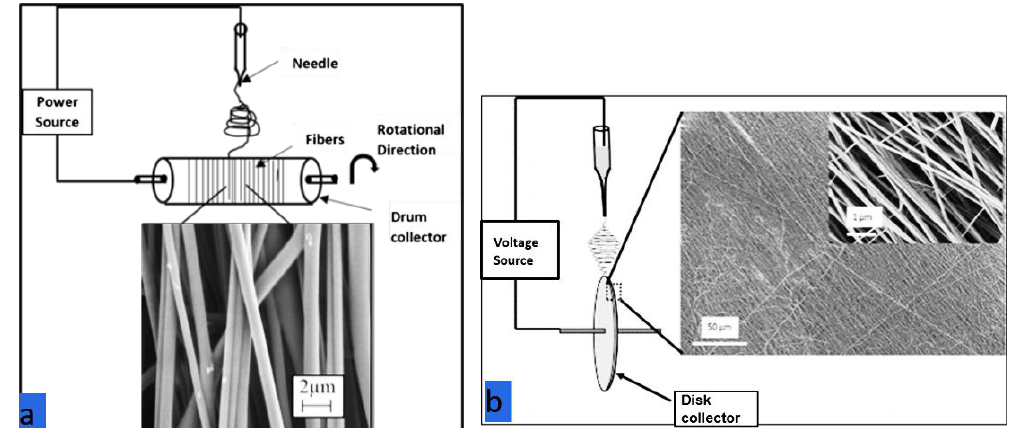
Figure 5. ( a ) Rotating drum collector. ( b ) Rotating disk collector [ 103 ] .